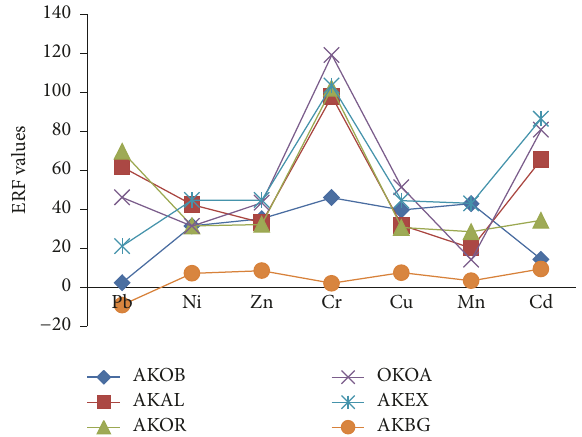
Figure 3: Plot of environmental risk factor values for metals in